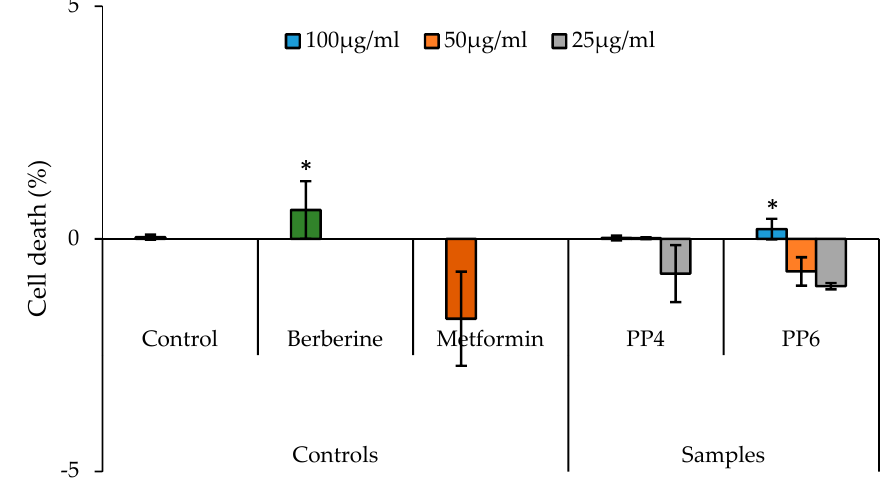
Figure 6. Toxicity of PP4 and PP6 isolated from L. tetragona extract to HepG2 cells used for glucose utilization assay. The data represent the mean ± SD (n = 5). A significant increase compared to the control ( p < 0.05) is indicated by “*”.